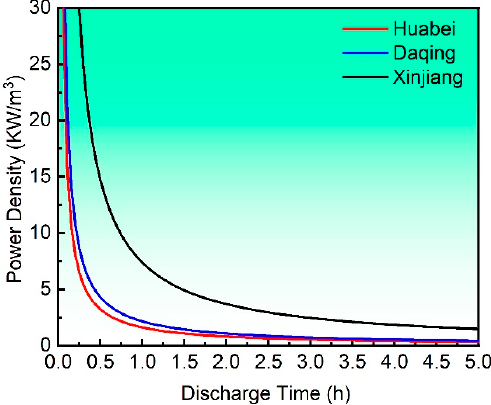
Figure 4. Variation of the power density with the discharge time of the gravity energy storage system in the three major oilfields.